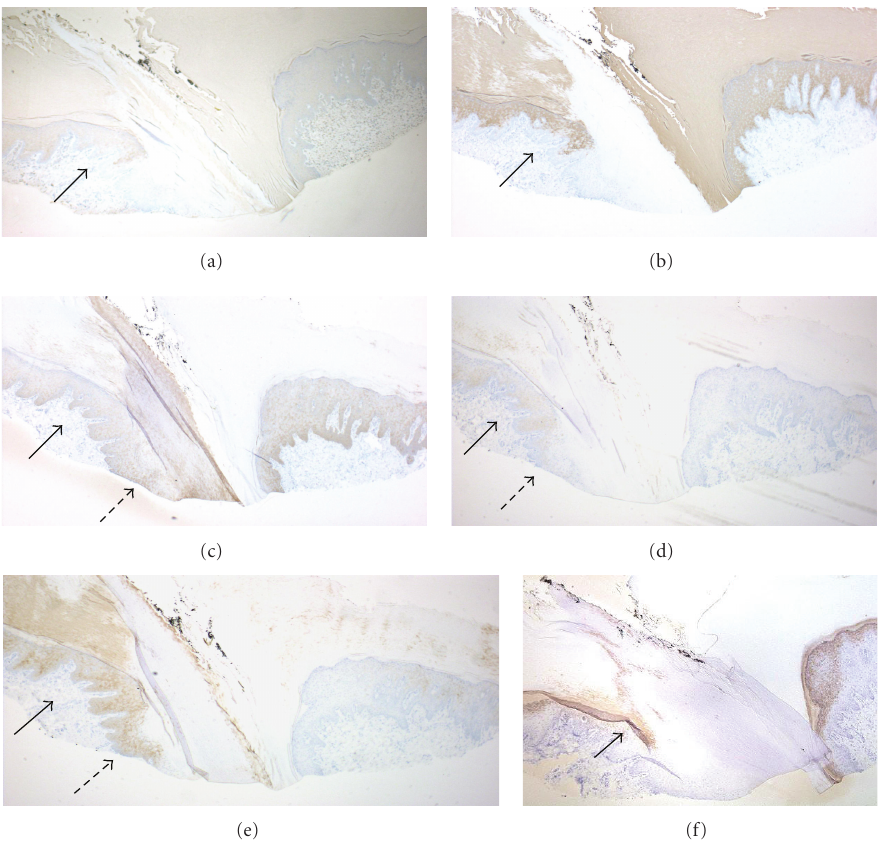
Figure 6: (a) K1 was positively stained in the suprabasal layers of the nail isthmus (arrow) (original magnification × 40). (b) K10 was expressed in the suprabasal layers of the nail isthmus (arrow) (original magnification × 40). (c) K14 was shown in the whole layers of the nail bed (dotted arrow) and nail isthmus (arrow) (original magnification × 40). (d) K16 was slightly detected in the suprabasal layers of the nail bed (dotted arrow) and nail isthmus (arrow) (original magnification × 40). (e) K17 was considerably expressed in the suprabasal layers of the nail bed (dotted arrow) and nail isthmus (arrow) (original magnification × 40). (f) Filaggrin was identified in the granular layer of the nail isthmus (arrow) (original magnification ×